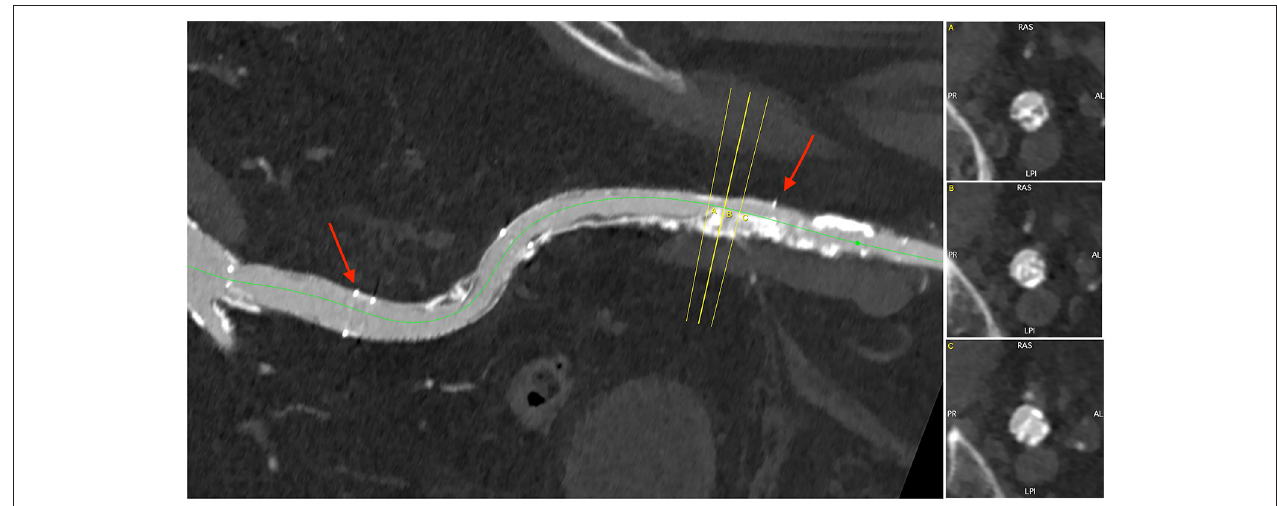
FIGURE 2 | 3D reconstruction of the iliofemoral axes, demonstrating the hypoplasia of the left axis and massive calcific involvement of the right axis.